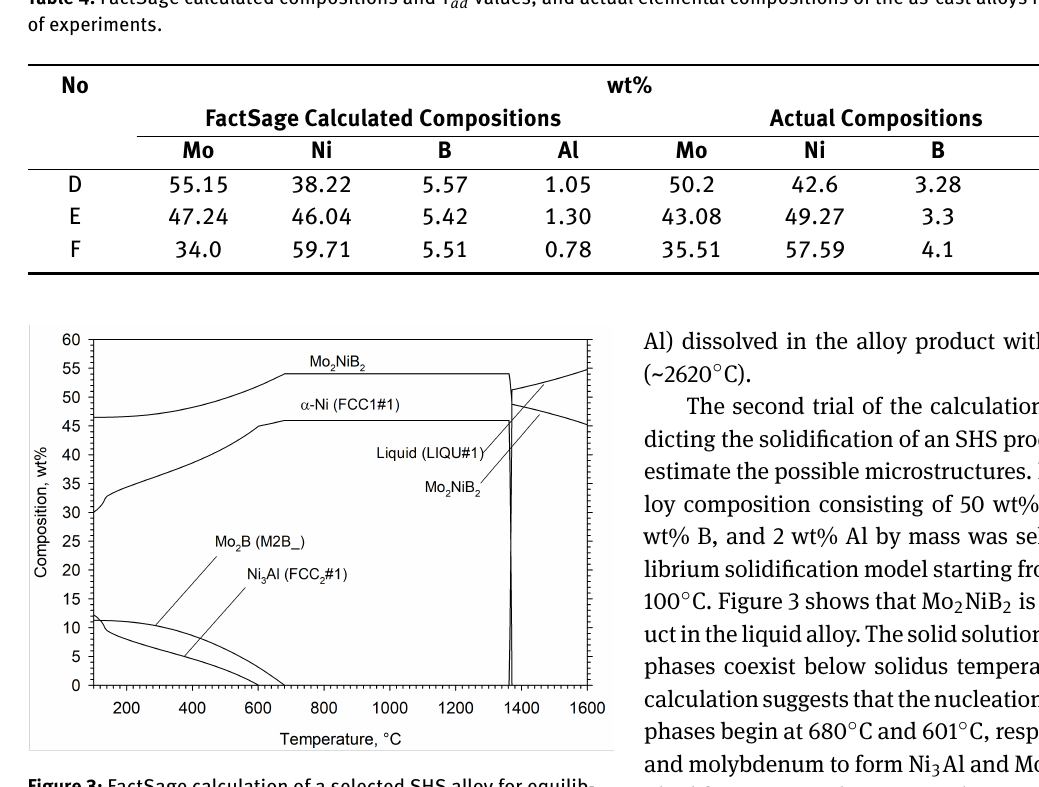
additions and T